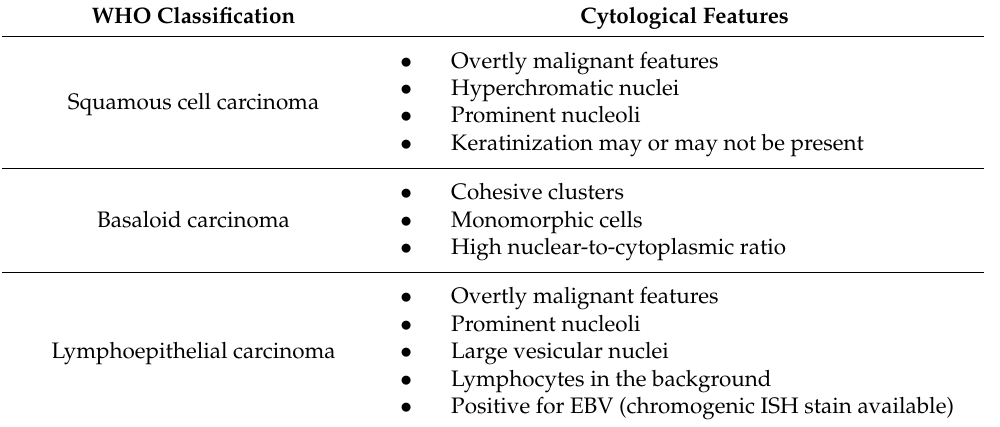
Table 2. Cytological features of thymic carcinoma